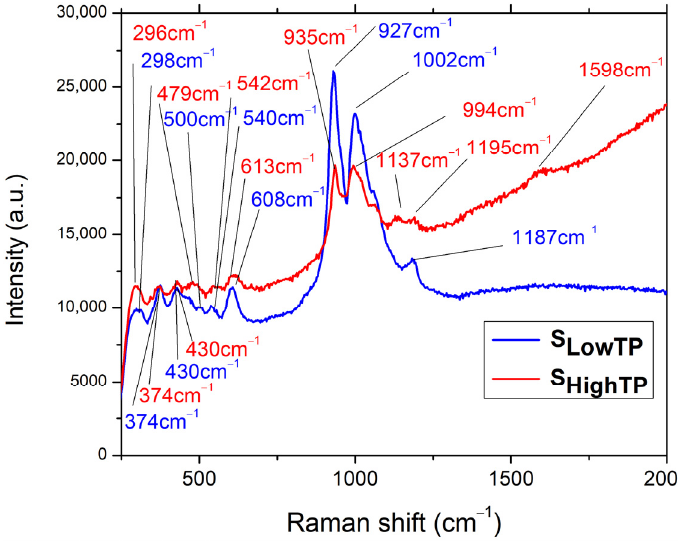
Figure 9. Raman spectra for S LowTP and S HighTP .